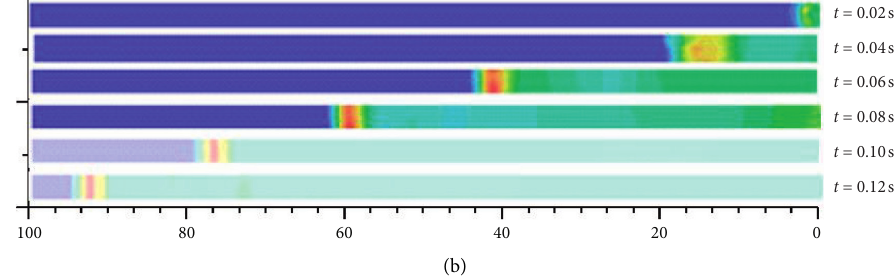
Figure 9: Propagation law of gas explosion shock wave at heading face (gas accumulation 467.46m 3 ). (a) Law of gas explosion shock wave propagation in heading face. (b) Law of gas explosion shock wave propagation in heading face ( X � 2.45m).